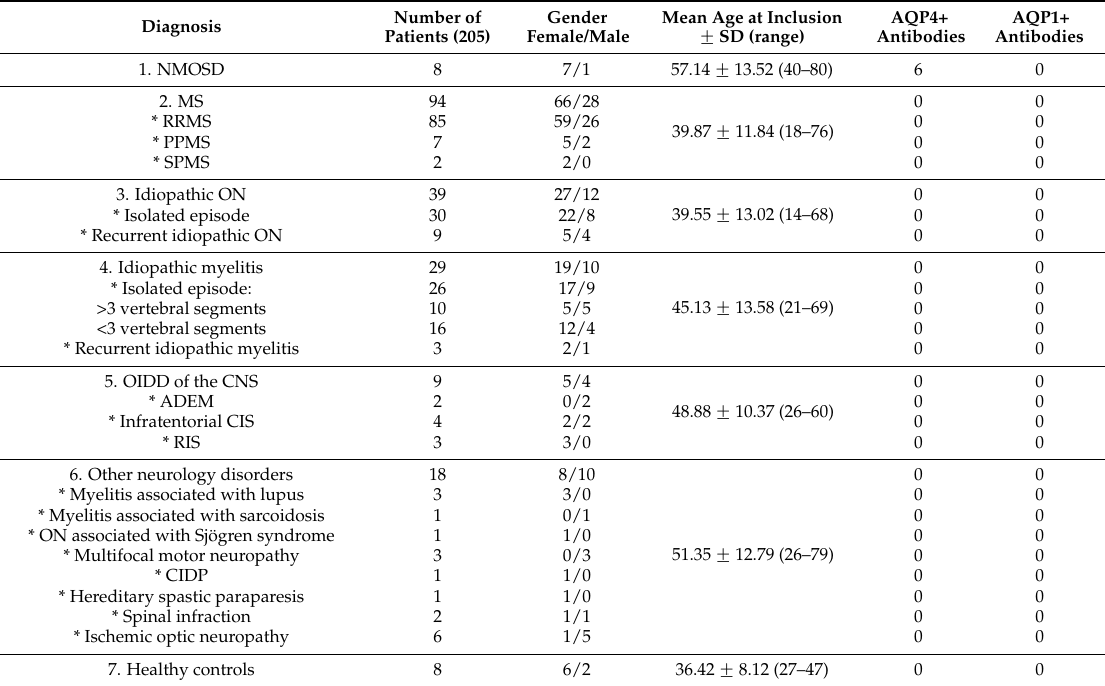
Table 1. Demographic and clinical variables of 205